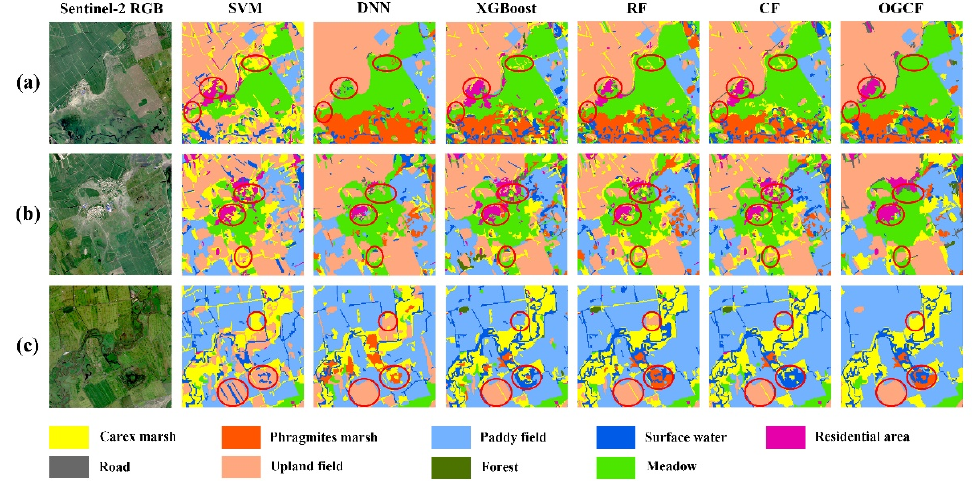
Figure 7. Three subregions ( a – c ) from remote sensing imagery with the corresponding classification maps. The first column shows the true color Sentinel-2 image (band 4, band 3, and band 2), and the following columns illustrate the classification maps obtained by the SVM, DNN, XGBoost, RF, CF, and OGCF models, respectively; details of the classification maps were labeled with red circles.